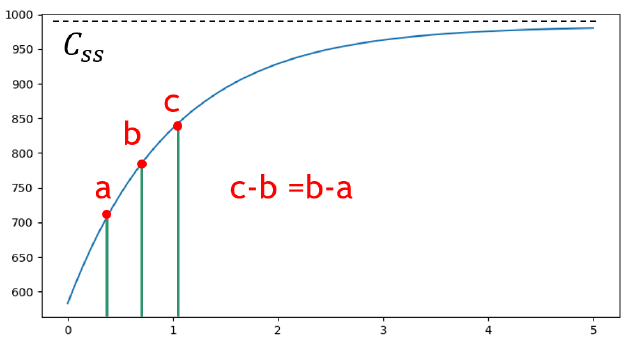
Figure 3. Trends in indoor CO 2